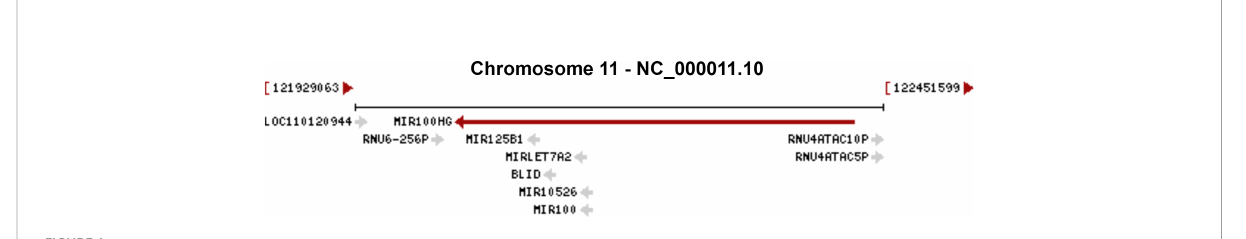
FIGURE 1 The genomic context of the MIR100HG. The genomic context of the MIR100HG was extracted from NCBI database (http://www.ncbi.nlm.nih. gov/gene/399959). Source: U.S. National Library of